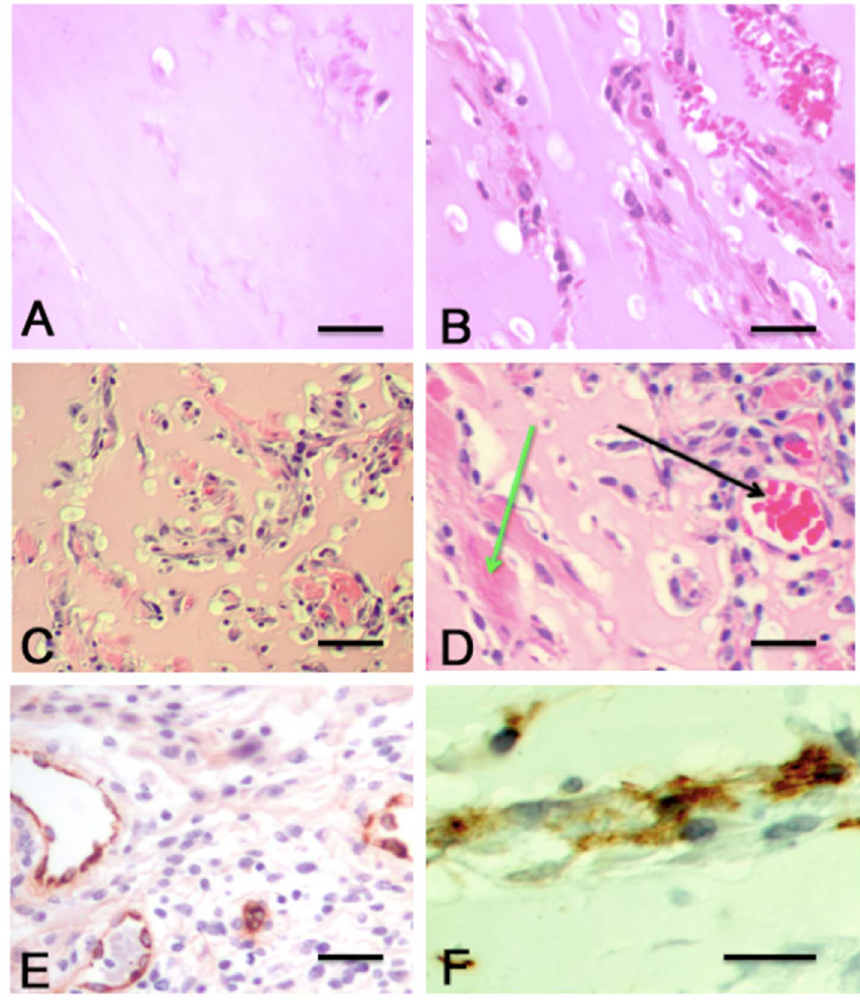
Figure 5. Cellular responses in the central assessment area of Matrigel plugs. Matrigel was injected in the presence or absence of 10 ng/mL IL-8, IL-6 or VEGF-A in 0.5 mL. Matrigel alone was injected as a control. Matrigel was supplemented with supernatants collected from ES-stimulated PBMCs or PBMCs cultured in media as a control and injected into rats. After 9 days, Matrigel plugs were excised, sectioned and analyzed. Representative observations are presented from a single experiment using 6 rats per group. (A) Matrigel alone (control) - H&E stain. (B) Vascular response in VEGF-A plug - H&E stain. (C) Cellular response in PBMC + ES Matrigel plug – H&E stain. (D) Lymphatic vessels (green arrow) together with blood vessels (black arrow) in an IL-6-treated Matrigel plug. (E) Example of anti-vWF staining of blood vessels in PBMC + ES Matrigel plug. (F) High power of the anti-podoplanin staining in an IL-6-containing Matrigel plug at 9 days. The scale bars represent 50 microns in A, B, D and E; 100 microns in 5C; and 10 microns in